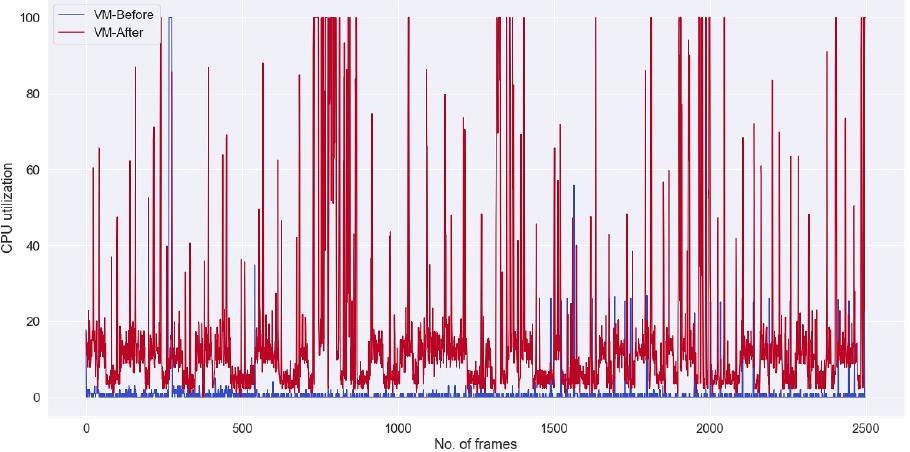
Figure 9. CPU utilization in VM before and after OpenStack installation.